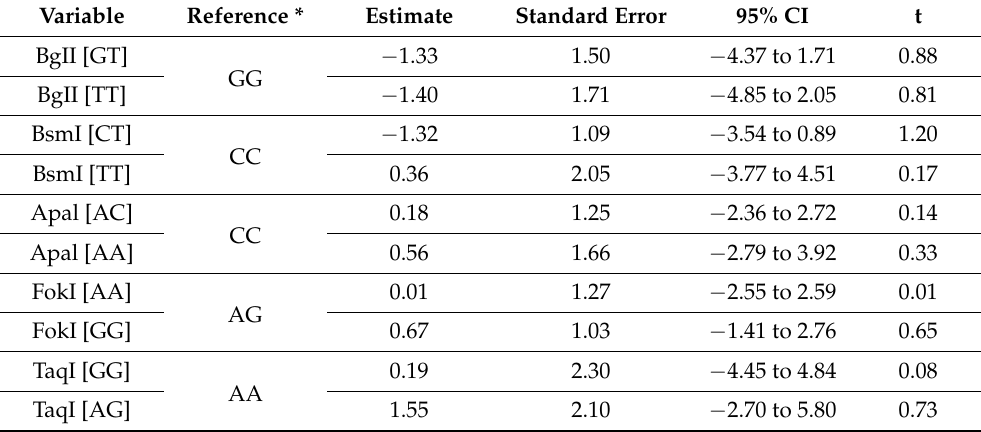
Table 3. Linear regression analysis to evaluate SNP–SNP